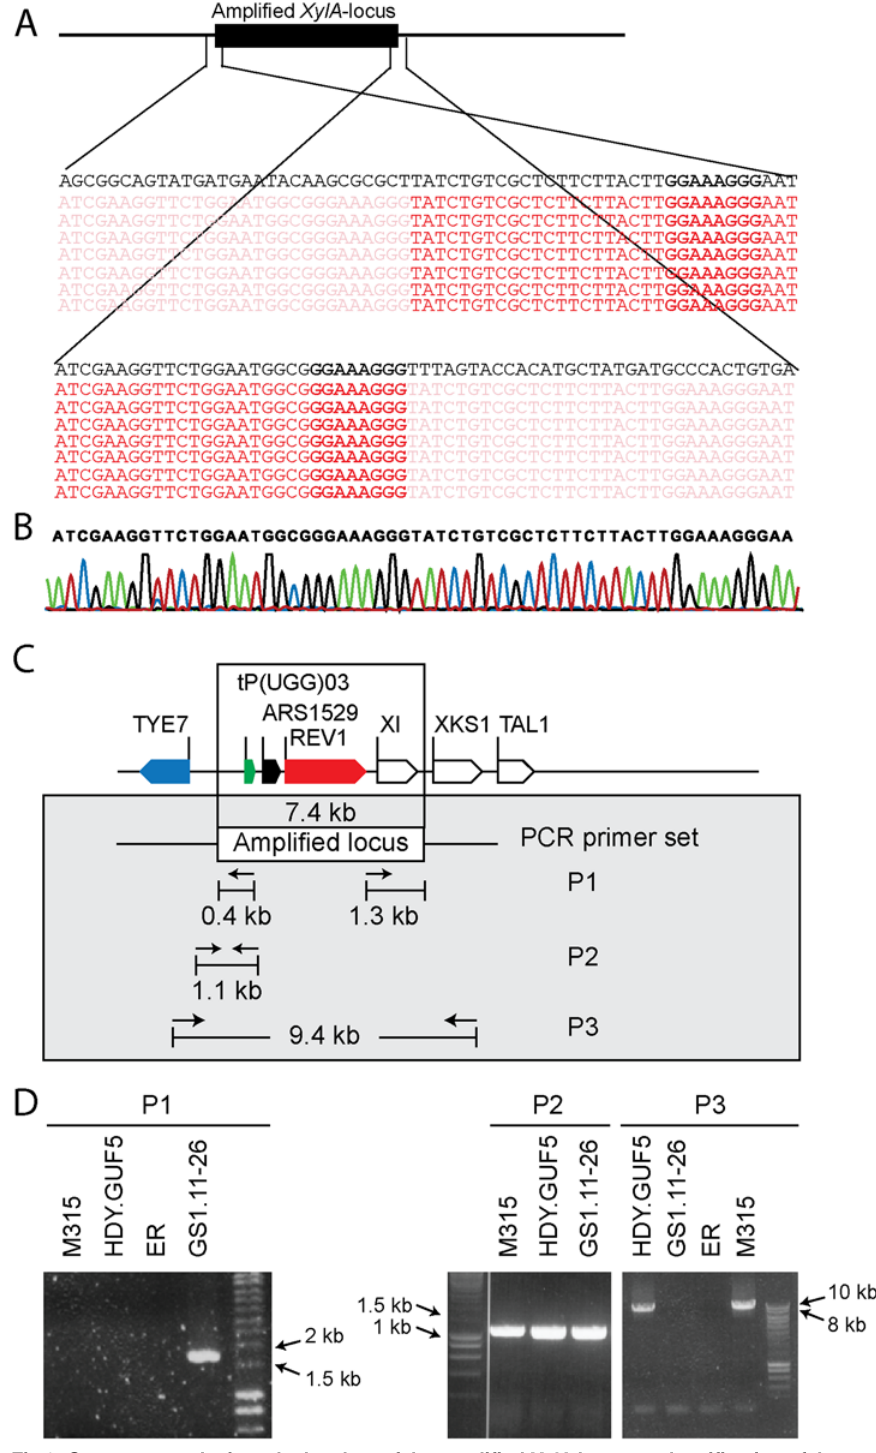
Fig 3. Sequence analysis at the borders of the amplified XylA -locus, and verification of the presence of circular or tandem repeats. (A) Illumina sequence reads mapped to the reference sequence at both ends of the amplified XylA -locus. Part of the reads that match to the reference sequence are shown in dark red, while sub-reads that do not match to the reference sequence are indicated in faded red color. The reference sequence is shown in black at the top of the reads. Microhomologies located on either ends of the